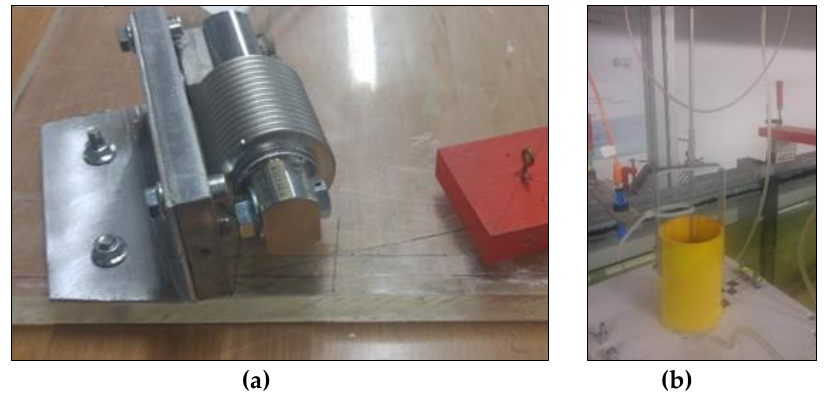
Figure 6. ( a ) Load cells (LCs), ( b ) hot-wire anemometer (HWA).